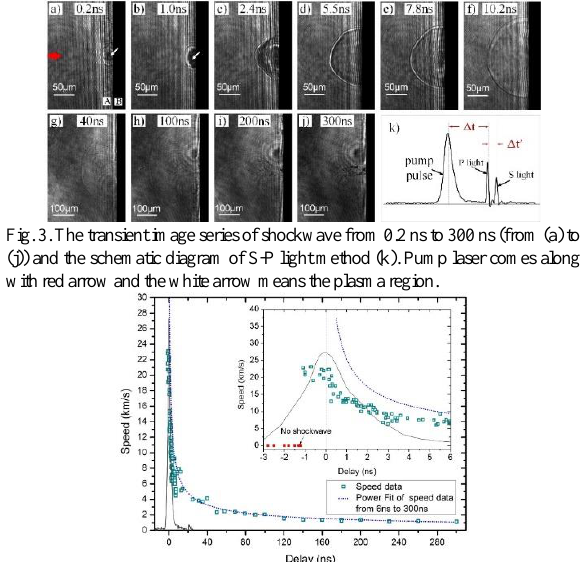
Fig. 4. The relationship between shockwave speed and delay from -1.2ns to 300ns under 0.77mJ pump energy. The blue dotted line is the fitting curve of shock wave speed along with delay. And the grey curve is the contour of pump laser duration.